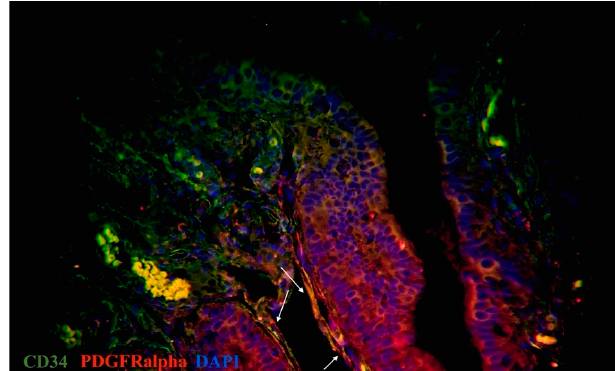
Figure 6. Double immunolabelling of human oviduct stained for PDGFR α (red, Alexa Fluor 594) and CD34 (green, Alexa Fluor 488) in study group. Nuclei stained by DAPI. Doubly immunopositive cell with an oval-shaped body and long cellular prolongation identified as telocytes (marked by arrows). Total magnification: ×400.